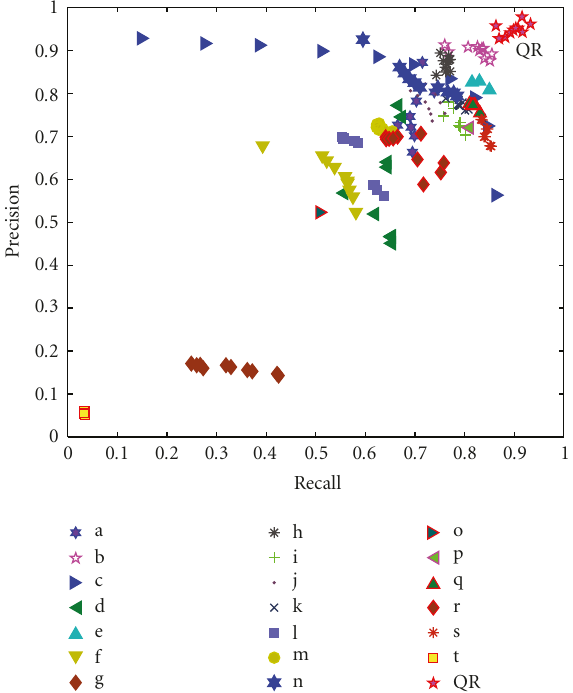
Figure 5: Results on the overall detection (cuts and transitions) based on the data provided by the organizers in TRECVID-2006. Our approach is labeled